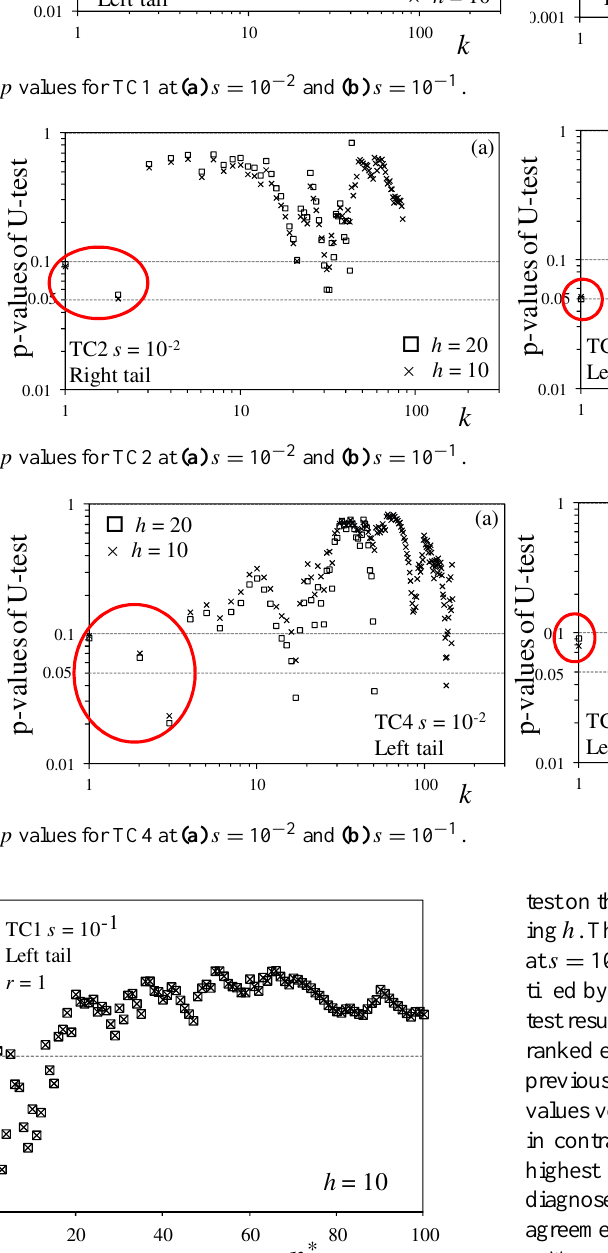
Fig. 9. DK test p values for TC1 and r = 1 at s = 10 − 1 .